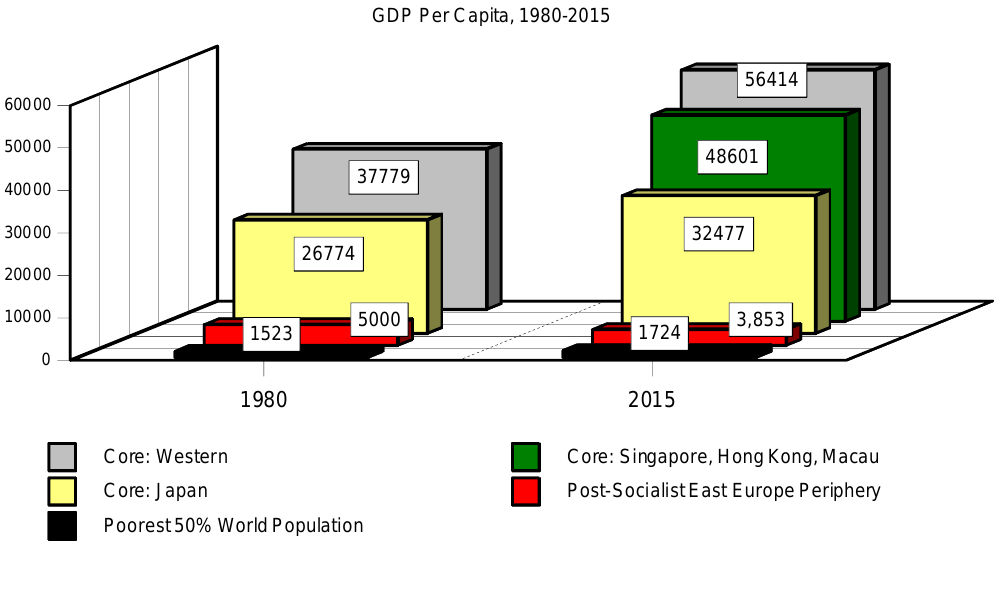
Part B. Inequality between Core and Semiperipheral